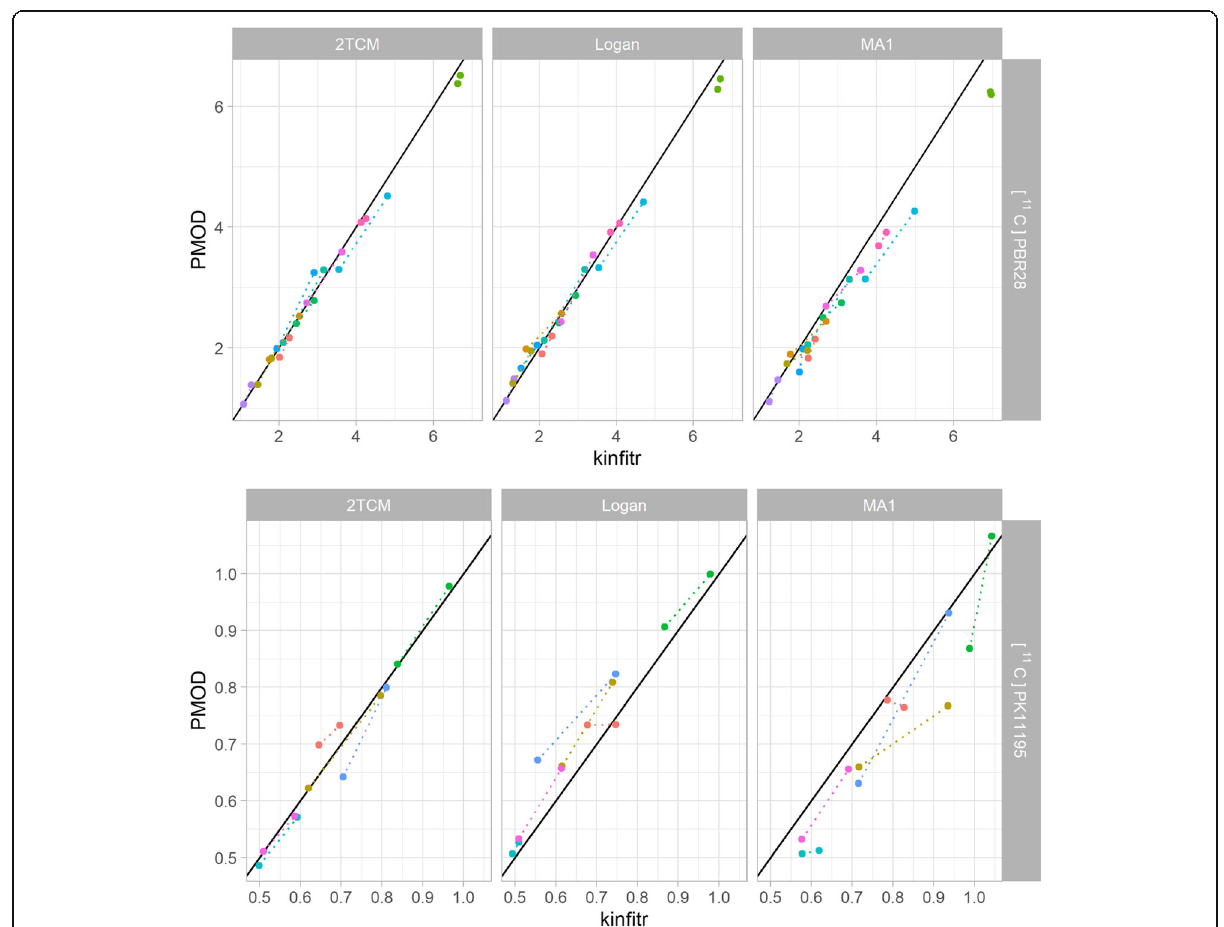
Fig. 2 Comparison of V T values calculated by kinfitr and PMOD. The relationship between binding estimates calculated by either kinfitr or PMOD. All results were derived from the frontal cortex region. The diagonal line represents the line of identity. Each colour corresponds to a different subject, and the dotted lines connect both measurements from the same